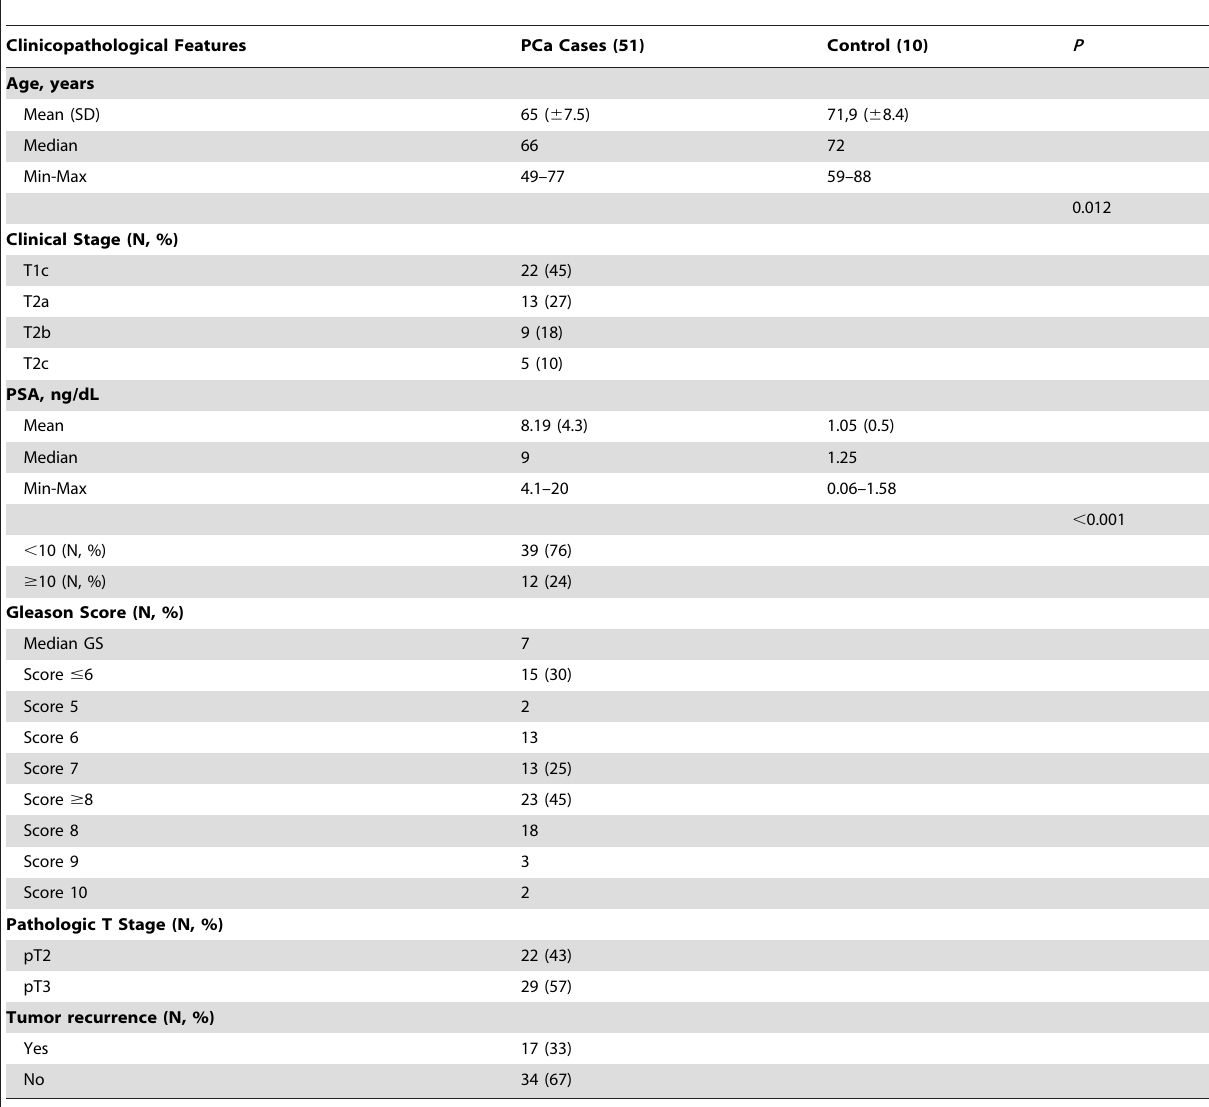
Table 2. Clinicopathological Features of 51 Patients with Localized Prostate Cancer Treated by Radical Prostatectomy.